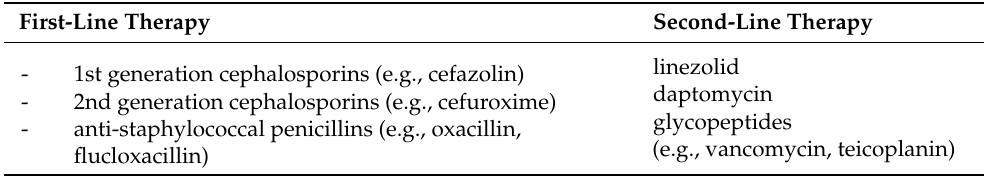
Table 1. Antibiotic substances defined as